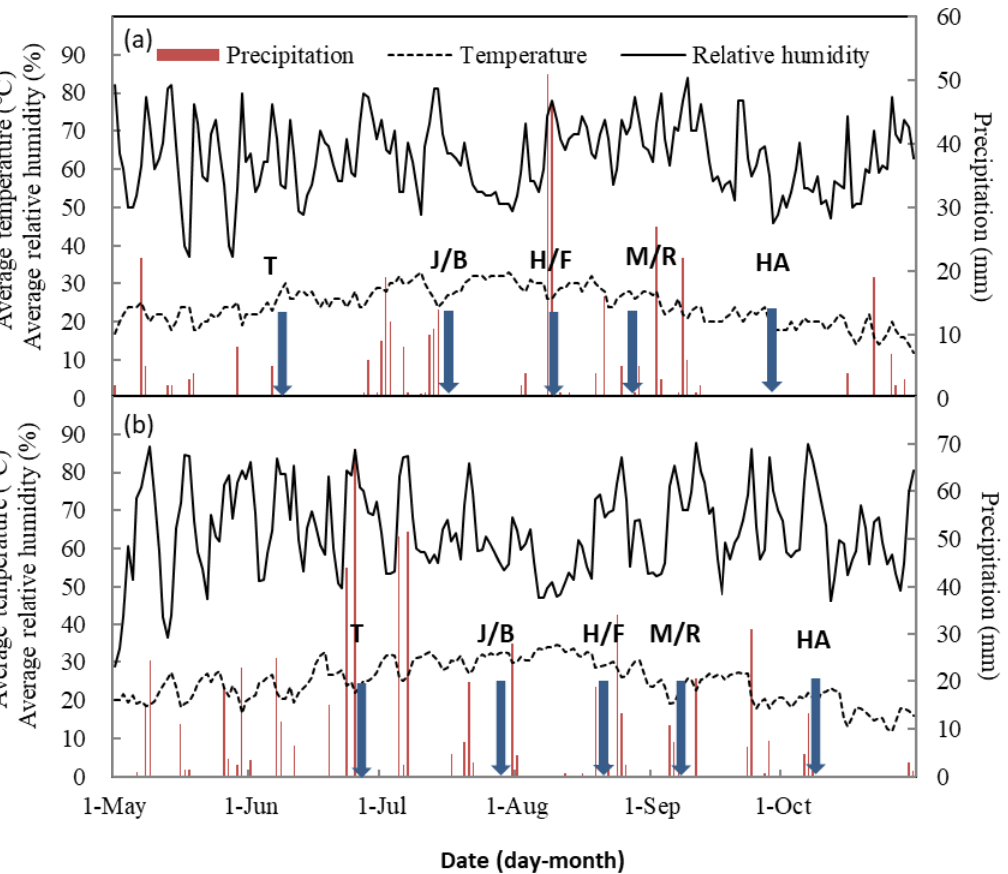
Figure 1. Average daily temperature, relative humidity, and precipitation during the rice growing season from May to October in ( a ) 2012 and ( b ) 2013. T, J/B, H/F, and M/R represent the beginning of tillering stage, jointing and booting stage, heading and flowing stage, and milky and ripening stage, respectively.